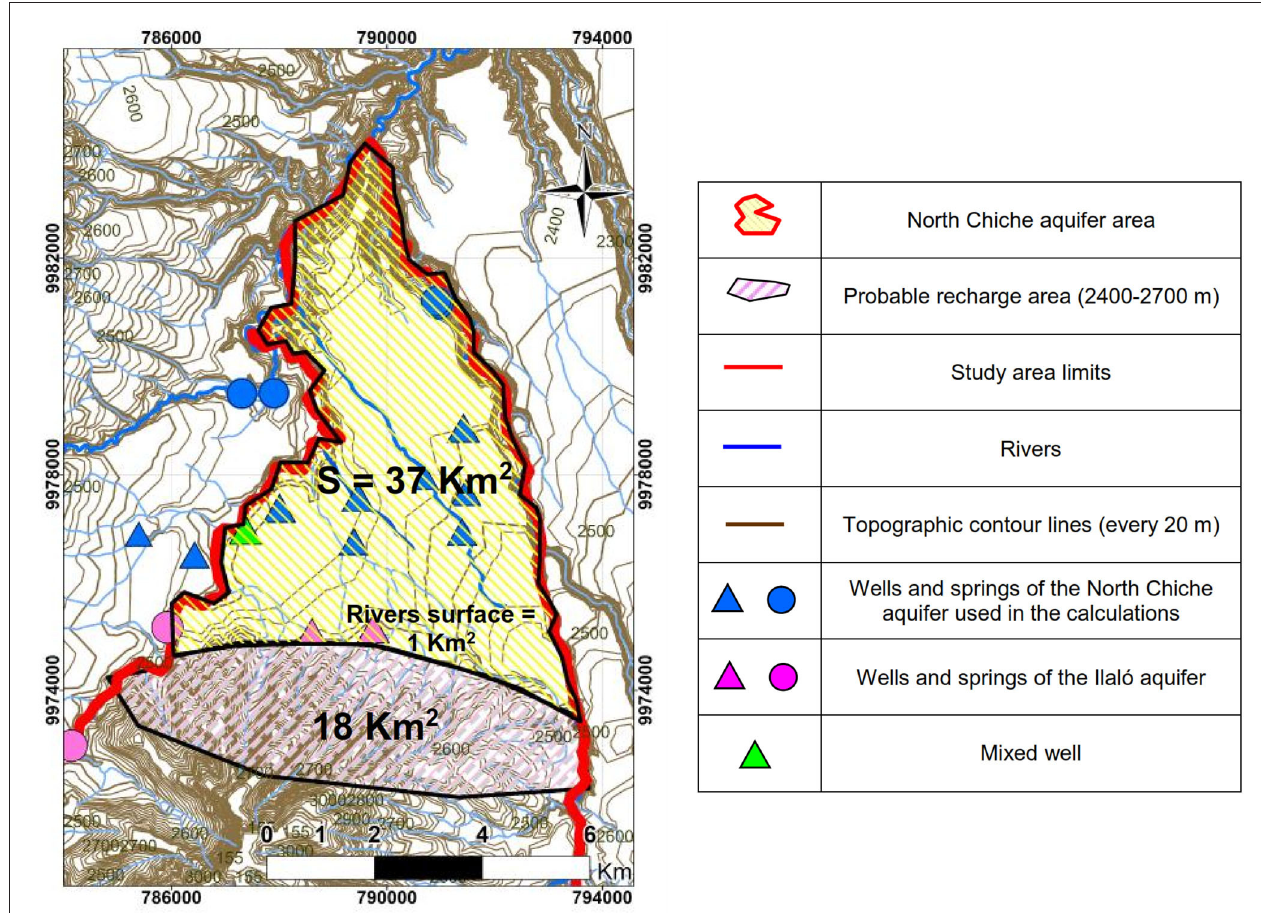
FIGURE 3 | North Chiche aquifer area used for water budget